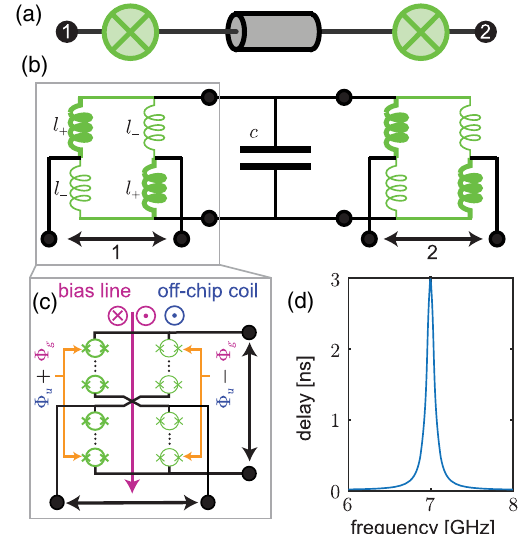
FIG. 3. Multiplying elements and delays realized in a super- conducting lumped-element circuit. (a) The model system [Fig. 2(a)] is constructed from two parallel instances of this network. (b) A lumped-element version of the network in (a), created with capacitors and tunable inductors arranged in a bridge geometry. (c) To create an inductive bridge circuit in a super- conducting microwave environment, four series arrays of SQUIDs are arranged in a figure-eight geometry and tuned with an off-chip magnetic coil producing a uniform flux Φ and an on- u chip bias line creating a gradiometric flux (cid:2) Φ . (d) Simulated g group delay for the circuit in (b) when its ports are connected to 50 ohm transmission lines. The bridge inductors are parametrized according to Eq. (2), with c ¼ 1 pF, l 0 ¼ 1 nH, and δ ¼ 0 . 2